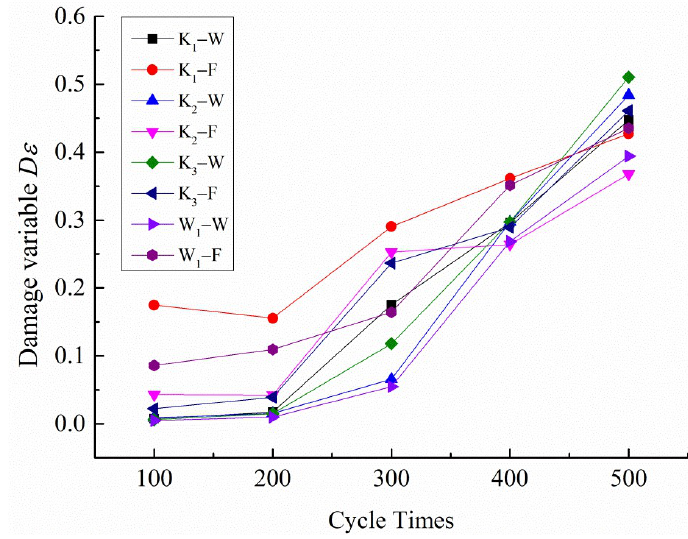
Figure 9. Curves of the damage variable D ε and cycle number.